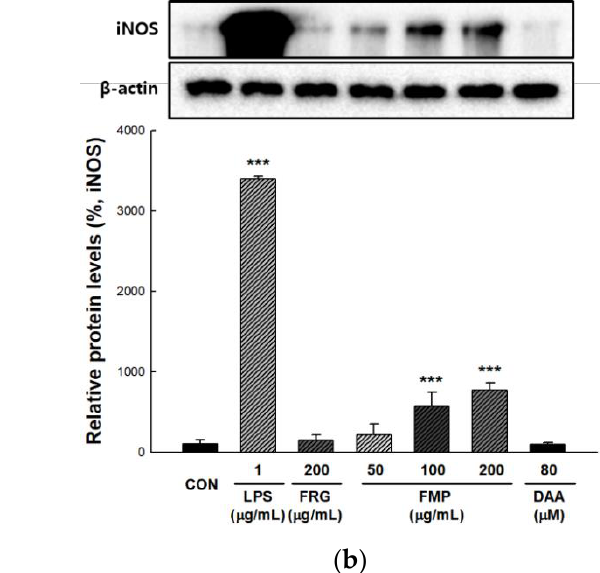
Figure 2. Effects of FMP on COX-2 and iNOS protein expression in RAW 264.7 cells. The cells were incubated with FMP and DAA for 24 h and harvested. The protein expression of ( a ) COX-2 and ( b ) iNOS was determined using immunoblotting. The relative protein expression levels were densitometrically quantified with β -actin. All values are expressed as the mean ± standard deviation. ** p < 0.01 and *** p < 0.001 vs. no treatment group. LPS, lipopolysaccharides; FRG, fermented red ginseng extract; FMP, fermented M. citrifolia polysaccharide; DAA, deacetylasperulosidic